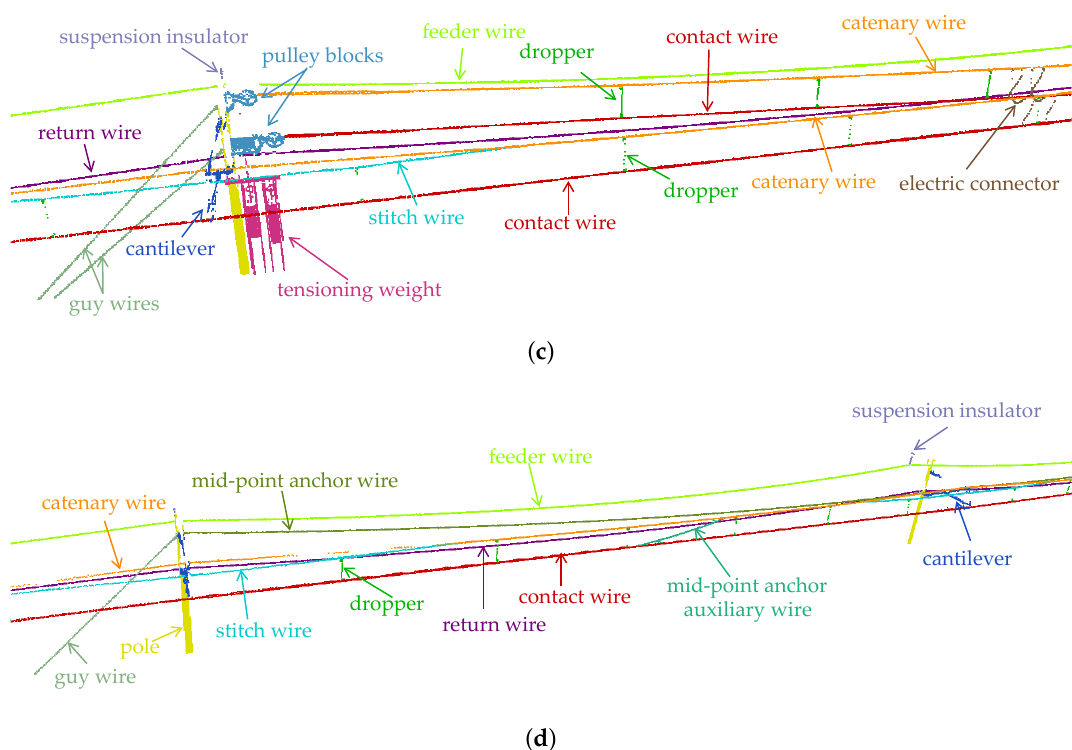
Figure 7. Overhead Contact System configuration of Chinese high-speed railway tagged with sixteen classes: ( a ) an image; and ( b – d ) MLS data (( b , c ) sections of insulated overlap and ( d ) a section with mid-point anchor).